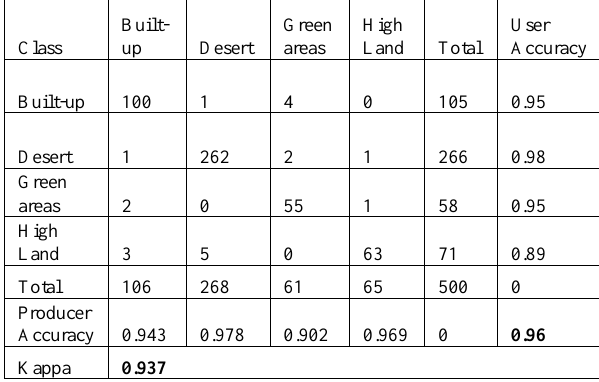
Table 1. Confusion matrix.